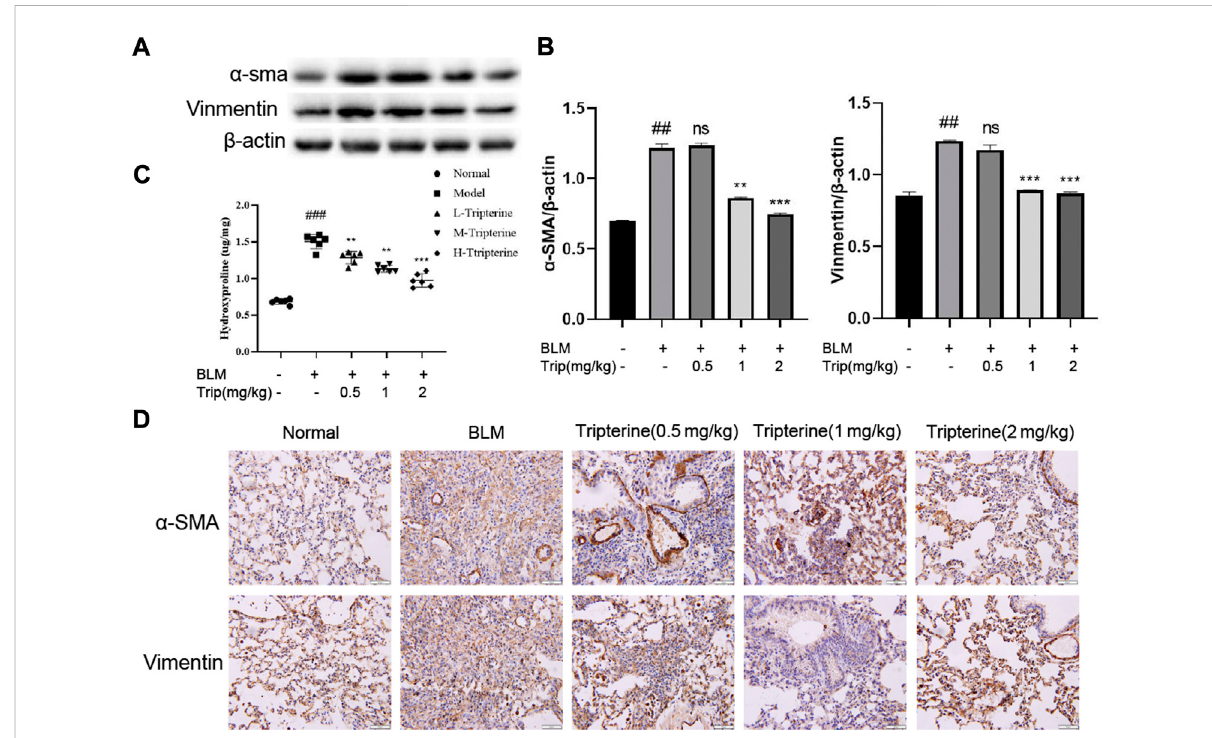
FIGURE 7 Effects of tripterine on epithelial-mesenchymal transformation markers of lung tissue in the connective tissue disease-related interstitial lung disease (CTD-ILD) model mice. (A) α -smooth muscle actin (SMA) and vimentin of lung tissues were analysed by Western blotting. (B) Expression changes in α -SMA and vimentin in the lung tissues of the mice were analysed by densitometry. (C) The hydroxyproline content in the lung tissues of the mice was determined by enzyme-linked immunosorbent assay. (D) Immunohistochemistry analysis of α -SMA and vimentin expression levels in the lung tissues of mice treated with tripterine. Scale bars: 50 μ m. Data reported in the fi gures are presented as the mean ± standard deviation, n =6ineachgroup.### p < 0.001vs.thenormalgroup;* p < 0.05,** p < 0.01,and*** p < 0.001vs.theBLM-treatedgroup.BLM,bleomycin (5 mg/kg); Trip,